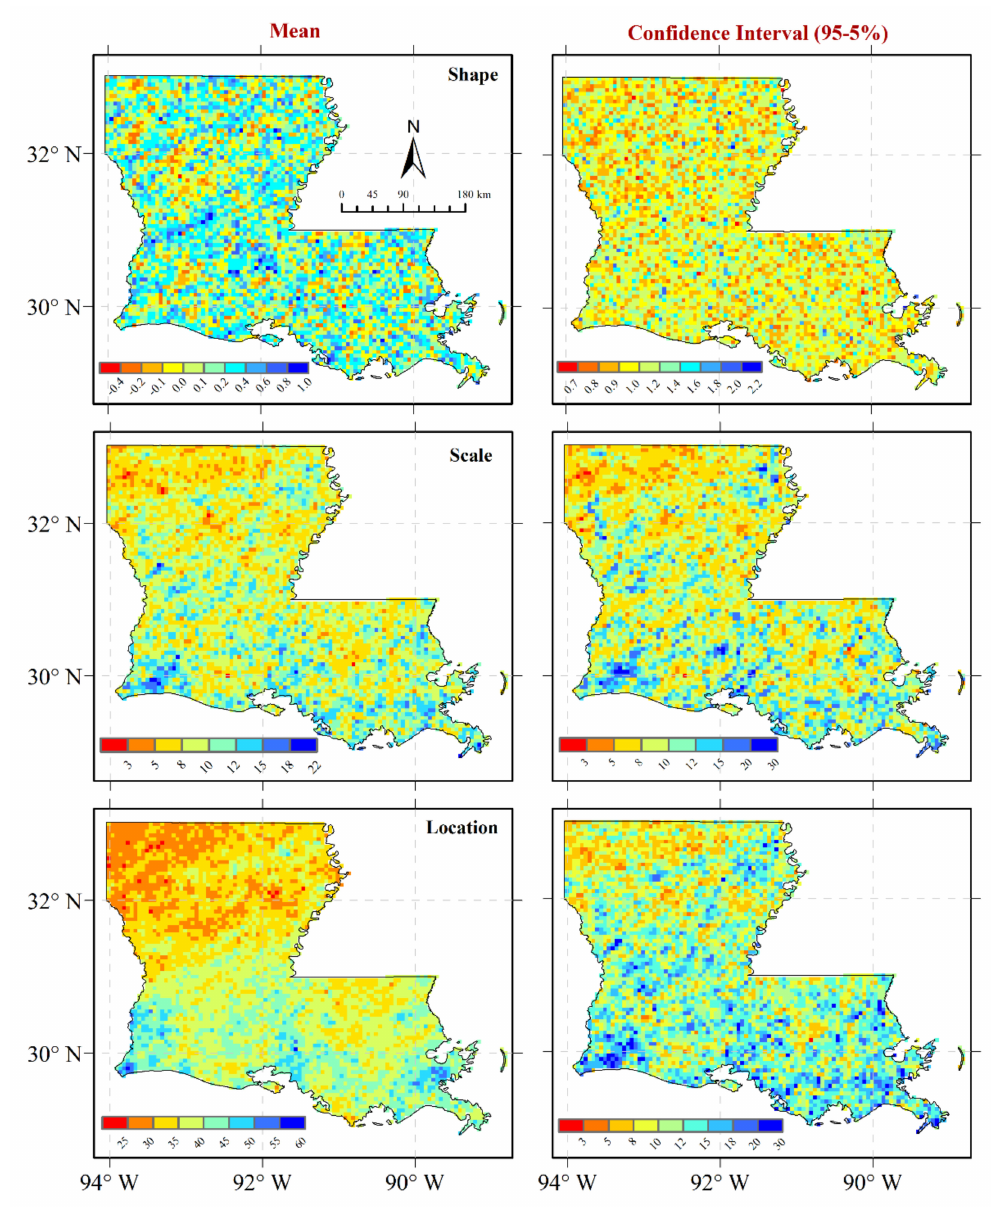
Figure 2. The GEV distribution parameters (shape, scale, and location parameters) from the pixel-based approach. Left Panels: Mean of 500 bootstrap runs. Right Panels: The confidence width (95–5%